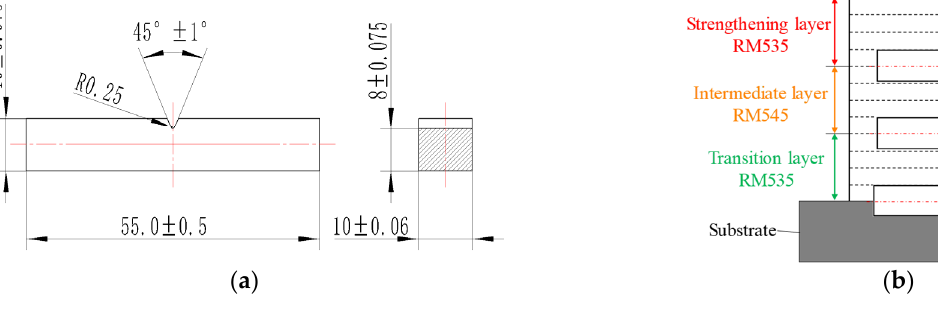
Figure 5. Sampling locations and observation points of impact fractures. ( a ) Impact specimen (unit: mm). ( b ) Sampling locations and fracture observation points.